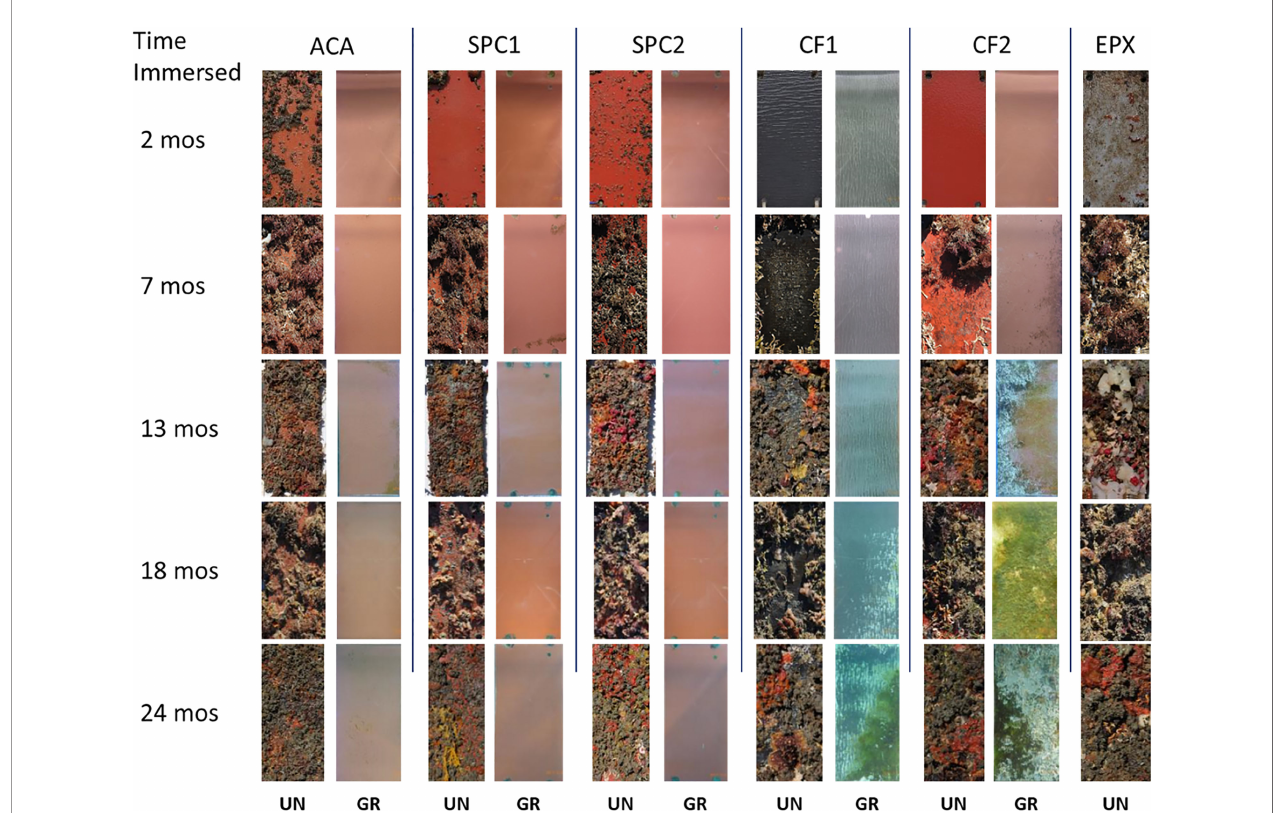
FIGURE 5 | Representative images of the panels over the duration of the experiment. UN is ungroomed, GR is groomed. Panels measured 15x30.5 cm (6x12 ”